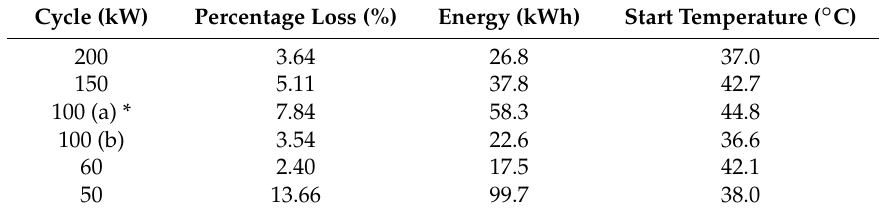
Table 5. Electrochemical energy loss from side reactions as a function of electrolyte temperature and power